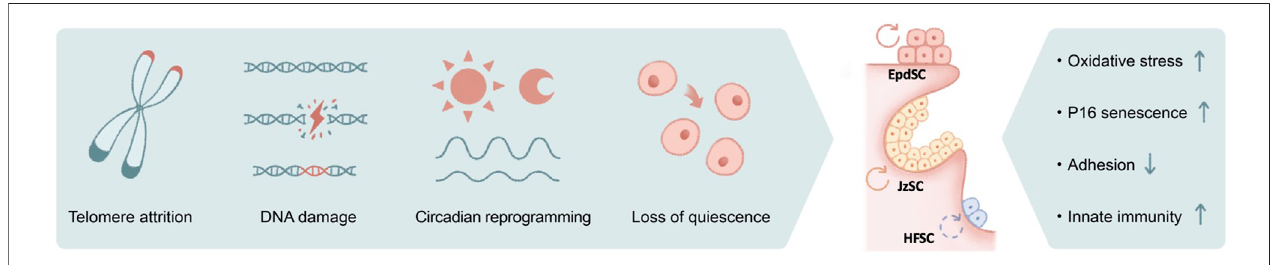
FIGURE 2 | The impact of genotoxic stress on skin aging. Numerous causes of genotoxic stresses including telomere attrition, DNA damage, circadian reprograming, and loss of quiescence could lead to stem cell functional decline in aging. The outcomes include increased oxidative stress, induction of P16 and cellular senescence, loss of cell adhesion, and activated innate immune pathways, among